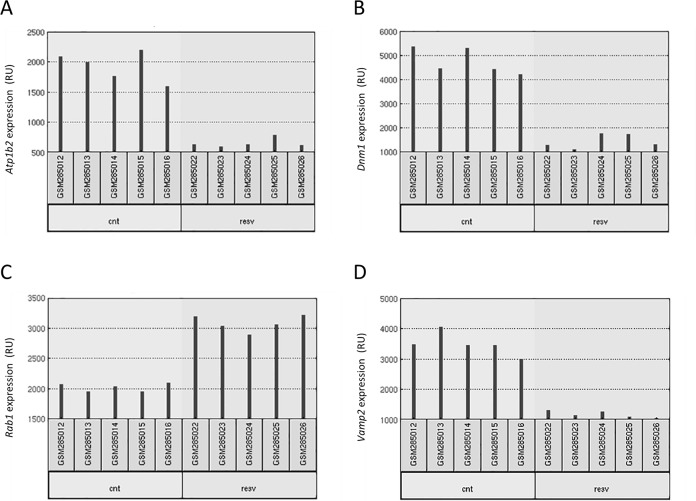
Raw data for four different genes: Atp1b2 (A), Dnm1 (B), Rab1 (C) and Vamp2 (D). Each red bar represents, in relative units (RU), the expression measurement from a sample. The five replicates correspond to five different animals (under control or under RSV-containing diets). (source: http://www.ncbi.nlm.nih.gov/geo/geo2r/?acc=GSE11291).